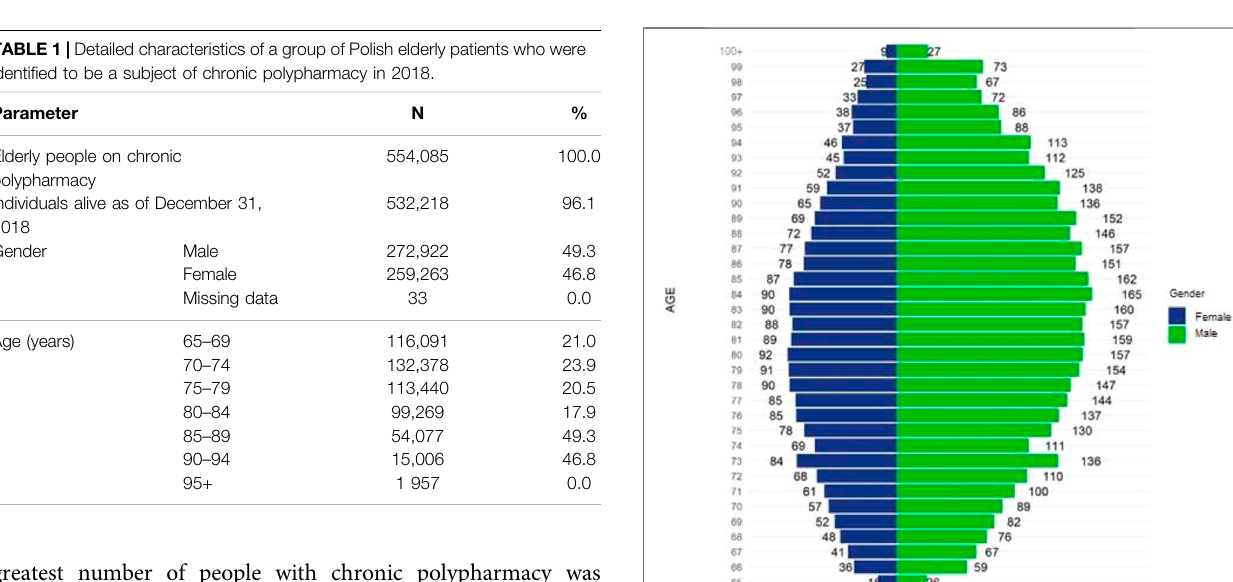
FIGURE 1 | Number of Polish elderly patients who during at least 80% of days within a speci fi c month of year 2018 were on fi ve or more drugs.